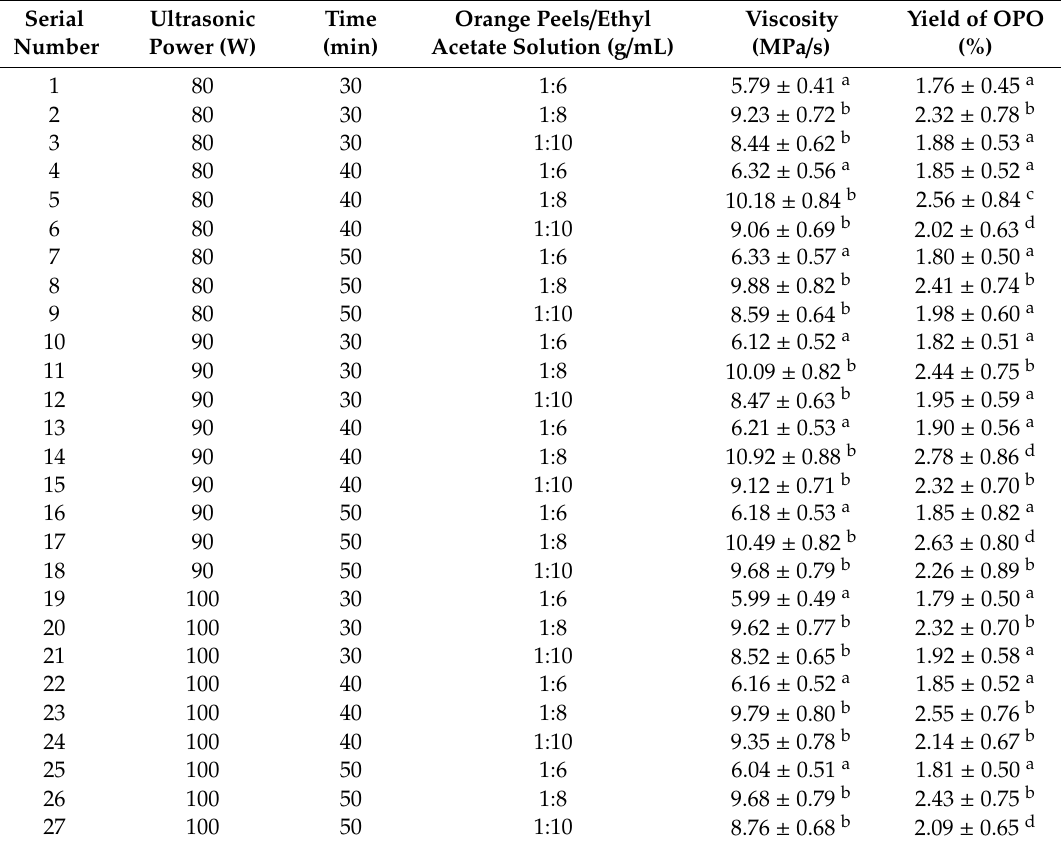
Table 2. The result of an orthogonal test for OPO